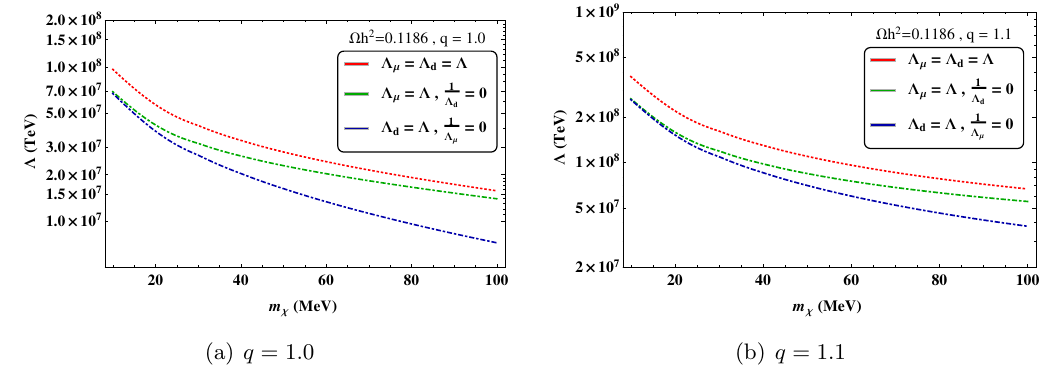
W h 2 = 0.1186 , q = 1.0